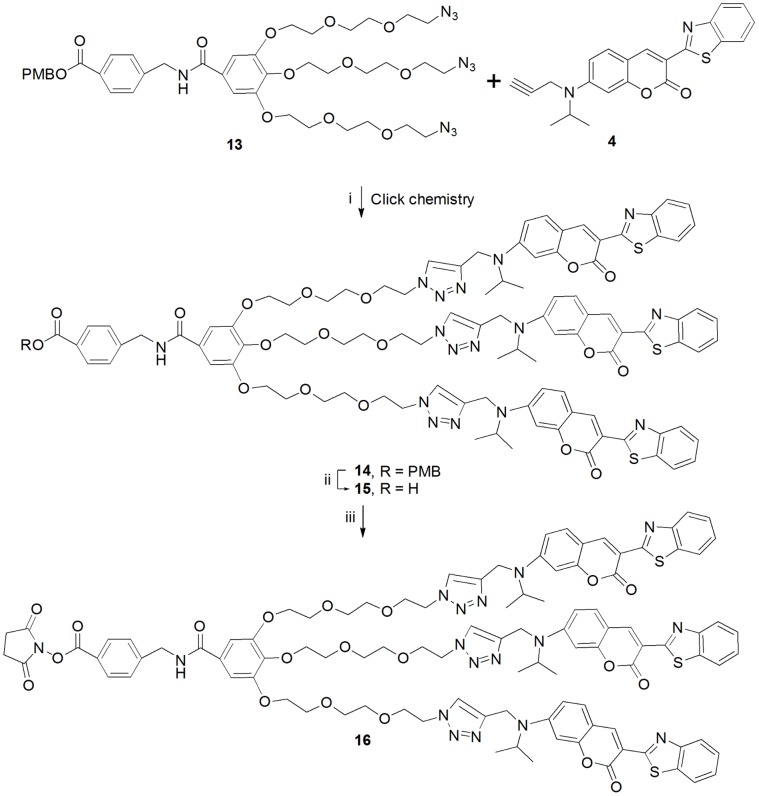
Synthesis of succinimidyl ester of coumarin dendrimer.(i) CuSO4.5H2O, Na ascorbate, DCM, H20, rt, 8 h, 60%. (ii) TFA, DCM, rt, 36 h, 95%. (iii) NHS, EDAC, DCM, rt, 6 h, 92%.